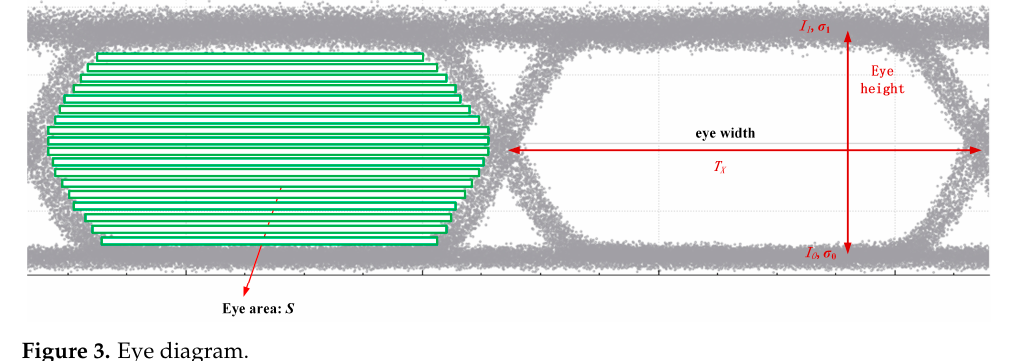
Figure 3. Eye diagram.